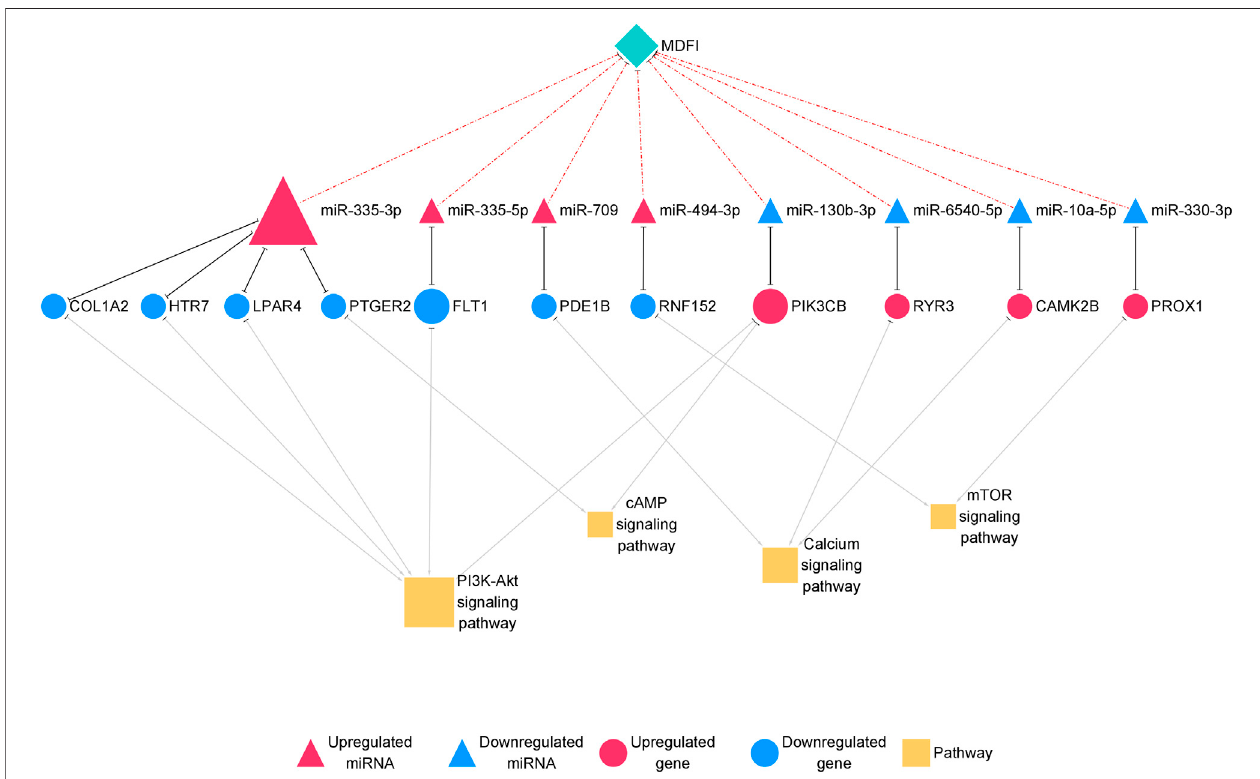
FIGURE7 | The miRNA-mRNAinteraction network related tomuscle fi ber type transformation.Thenetworkdisplays miRNA-mRNAinteractions.Nodes represent miRNAandmRNA,andedgesrepresentgeneinteractions. ThemiRNAsareshowninred;genesareshowninblue,andpathwaysareshown inyellow.ThemiRNAsare depicted by triangles, the mRNAs as circles, and the pathways as